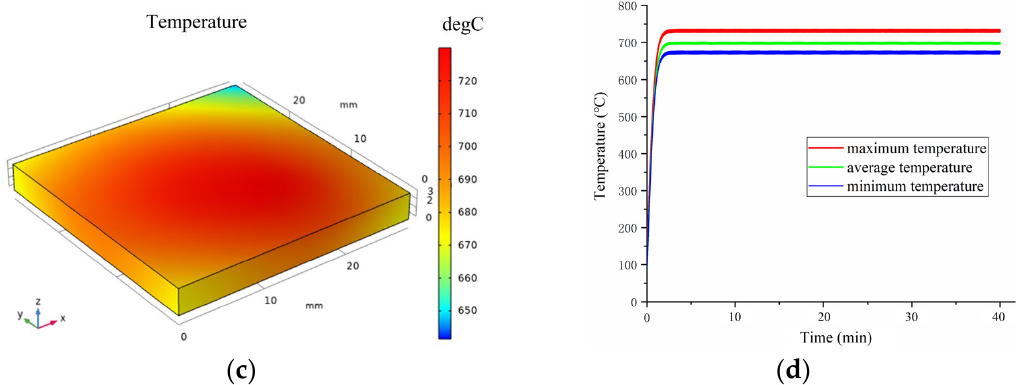
Figure 2. Laser annealing temperature simulation: ( a , b ) unacceptable results, ( c ) an optimized result, and ( d ) temperature distribution during annealing time.